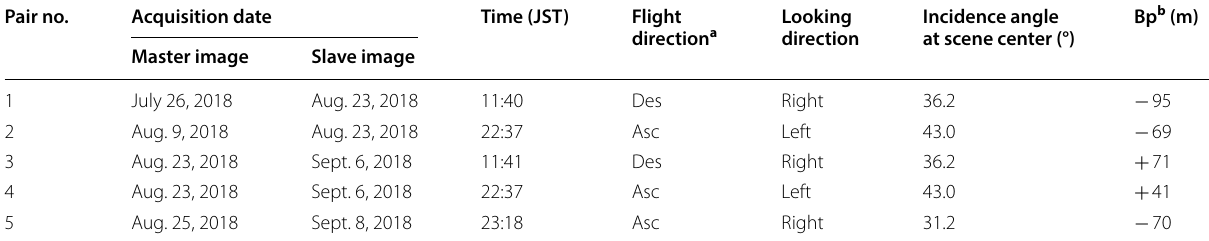
a Descending (Des) and ascending (Asc) orbits b Perpendicular baseline